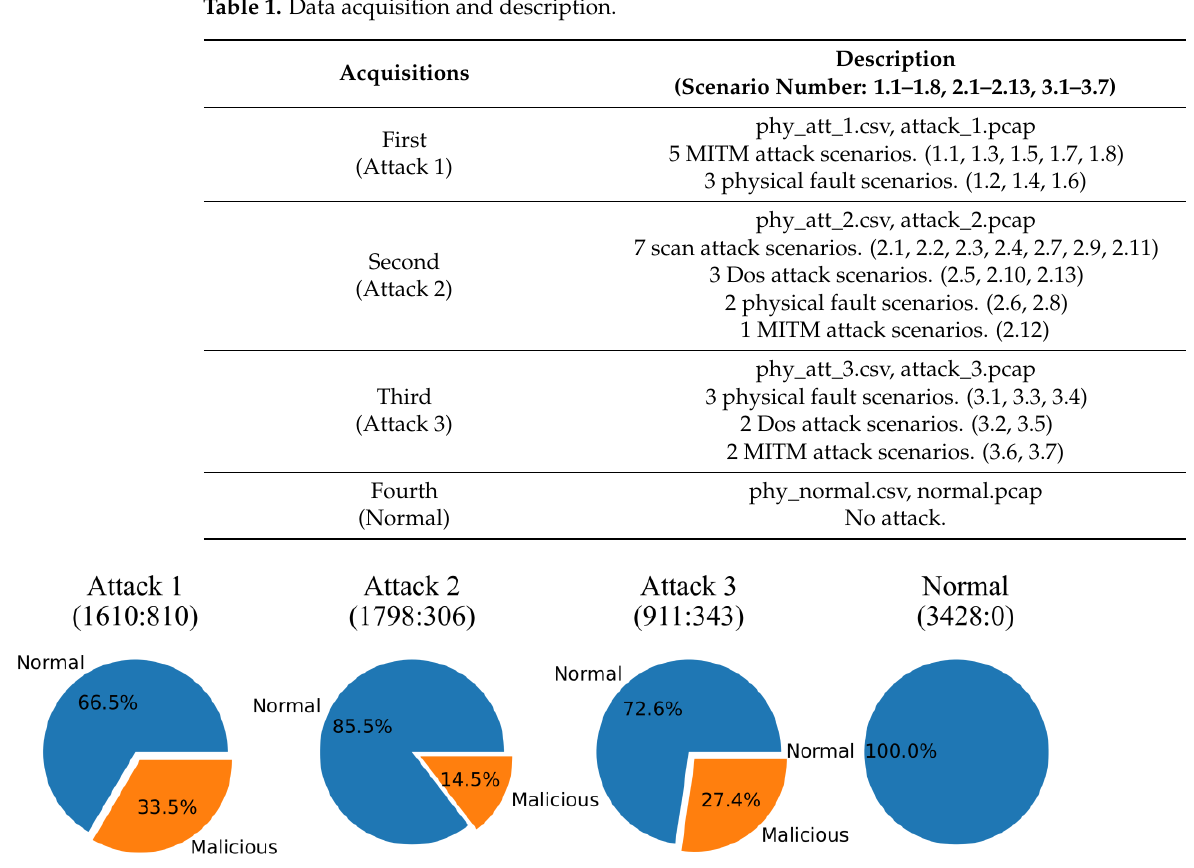
Figure 1. Number and proportion of samples divided into normal and malicious.